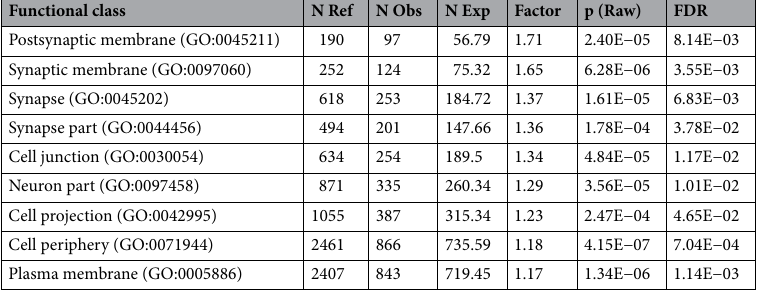
Table 6. Results from the GO cellular component analysis using genes selected by taking the same sign logistic regression coefficients for all SNPs in the Dalhousie and Würzburg samples that